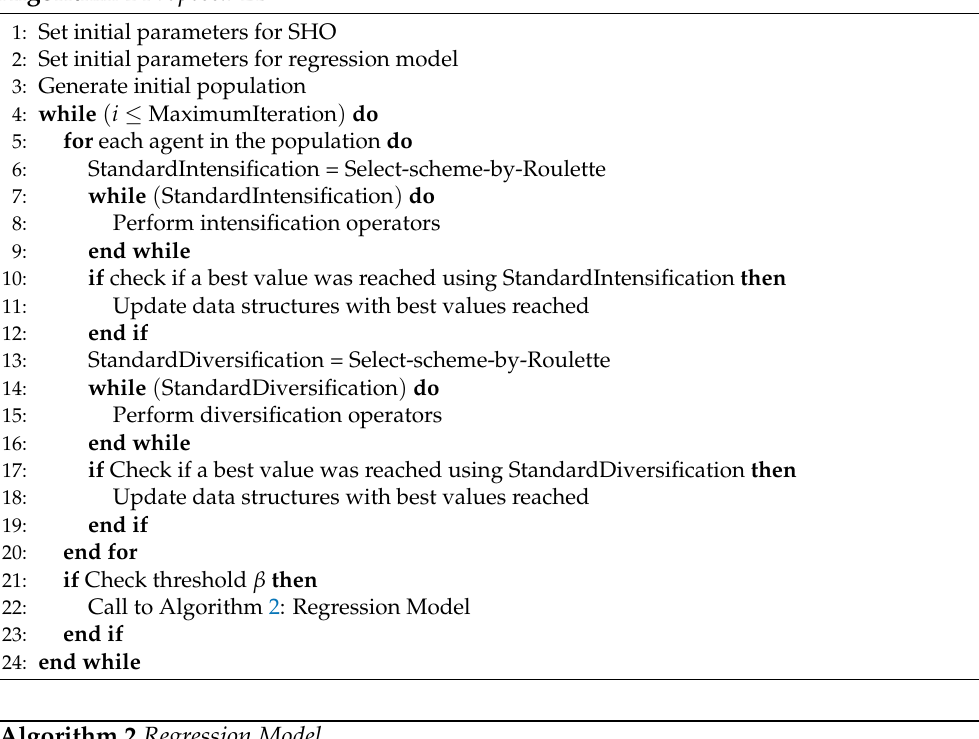
Algorithm 1 Proposed LB 2